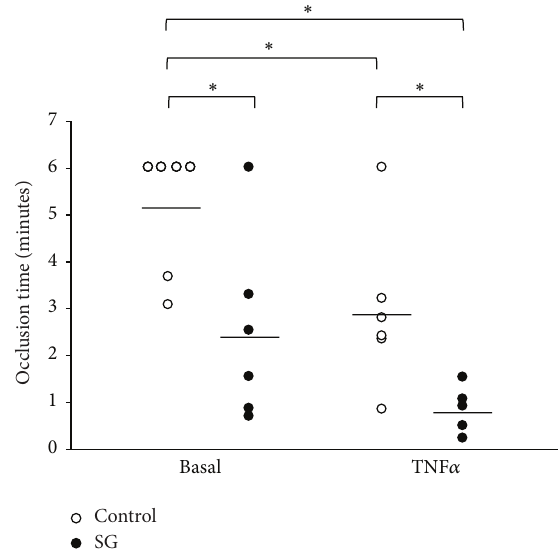
Figure 2: Inhibition of SHP-1 leads to accelerated arteriolar throm- busformation invivo .Timetothromboticarteriolarvesselocclusion in vivo , as measured in the ferric chloride superfusion model in the dorsal skinfold chamber in mice, was significantly accelerated when animals were treated with the SHP-1 inhibitor sodium sti- bogluconate (10 𝜇 g/mL, 30 min) under basal conditions. TNF 𝛼 - induced inflammation itself (TNF 𝛼 5 ng/mL, 4h) led to accelerated thrombus formation, but the effect was further increased by SHP- 1 inhibition. SG: sodium stibogluconate. ∗ Significantly different at 𝑃 < 0.05 ( 𝑛 = 5 - 6 ).